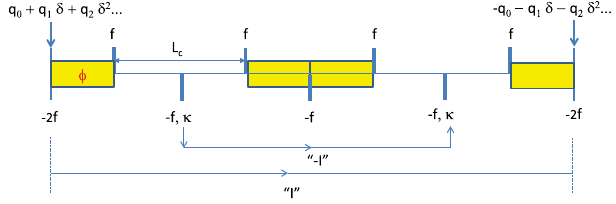
FIG. 7. A schematic layout of a chromatic correction module in